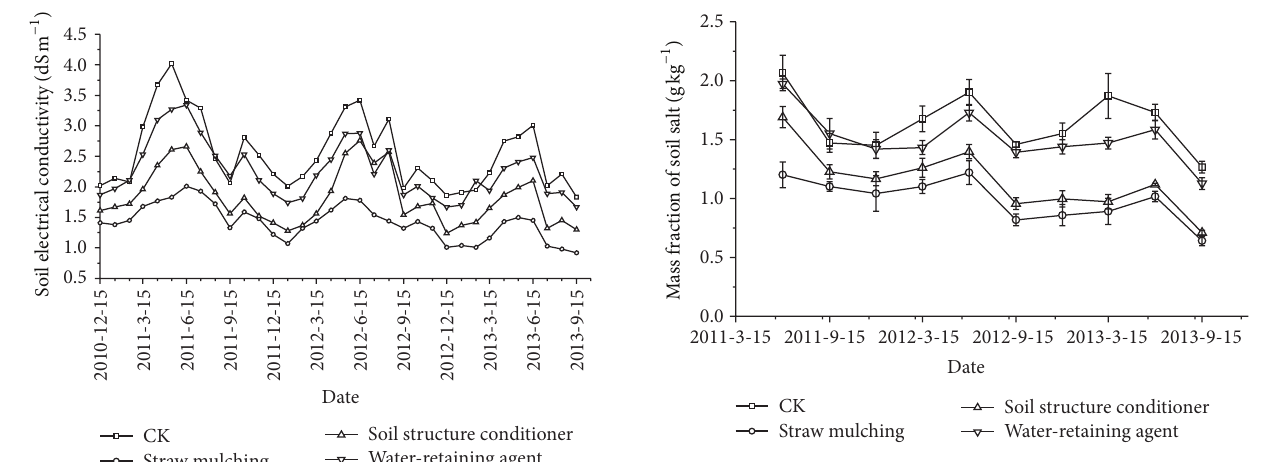
Figure 2: Mass fraction of soil salt in plough layer with regulatory